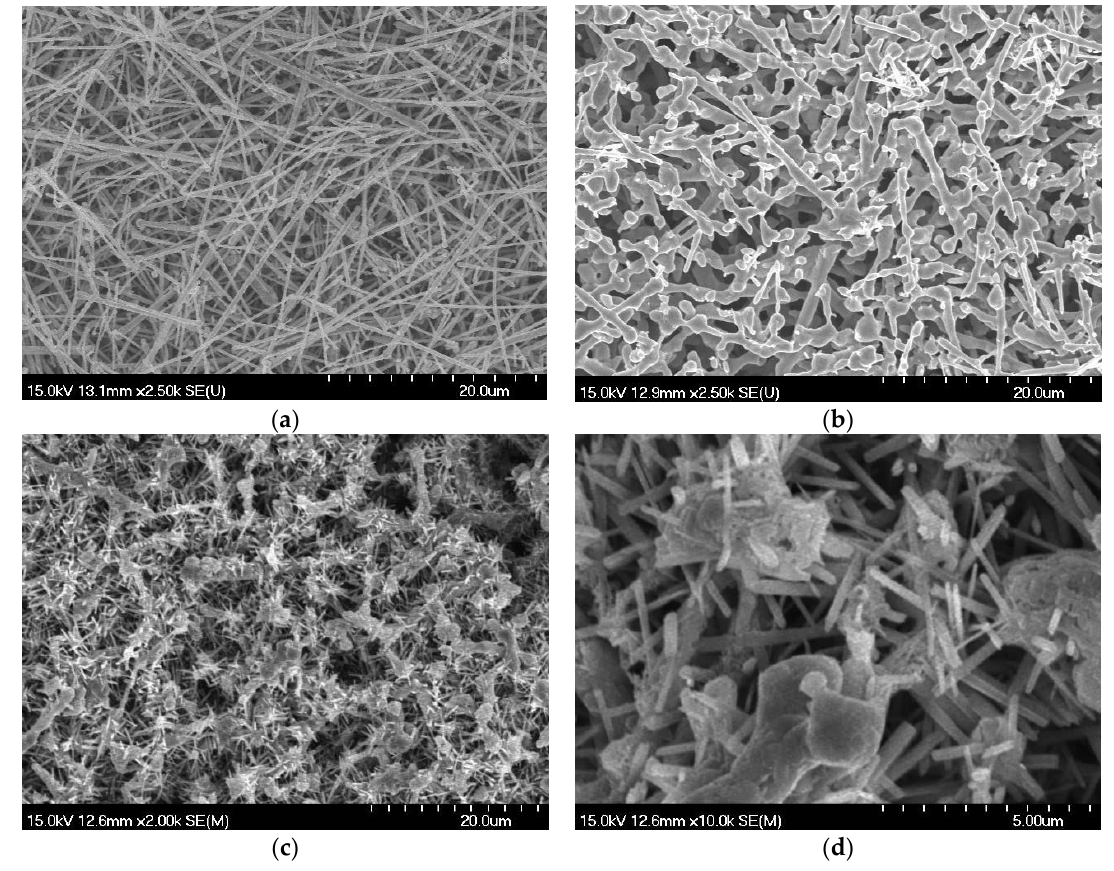
Figure 1. SEM images of ( a ) CuNW film before annealing, ( b ) CuNWE, ( c ) and ( d ) CuO/CuNWE.